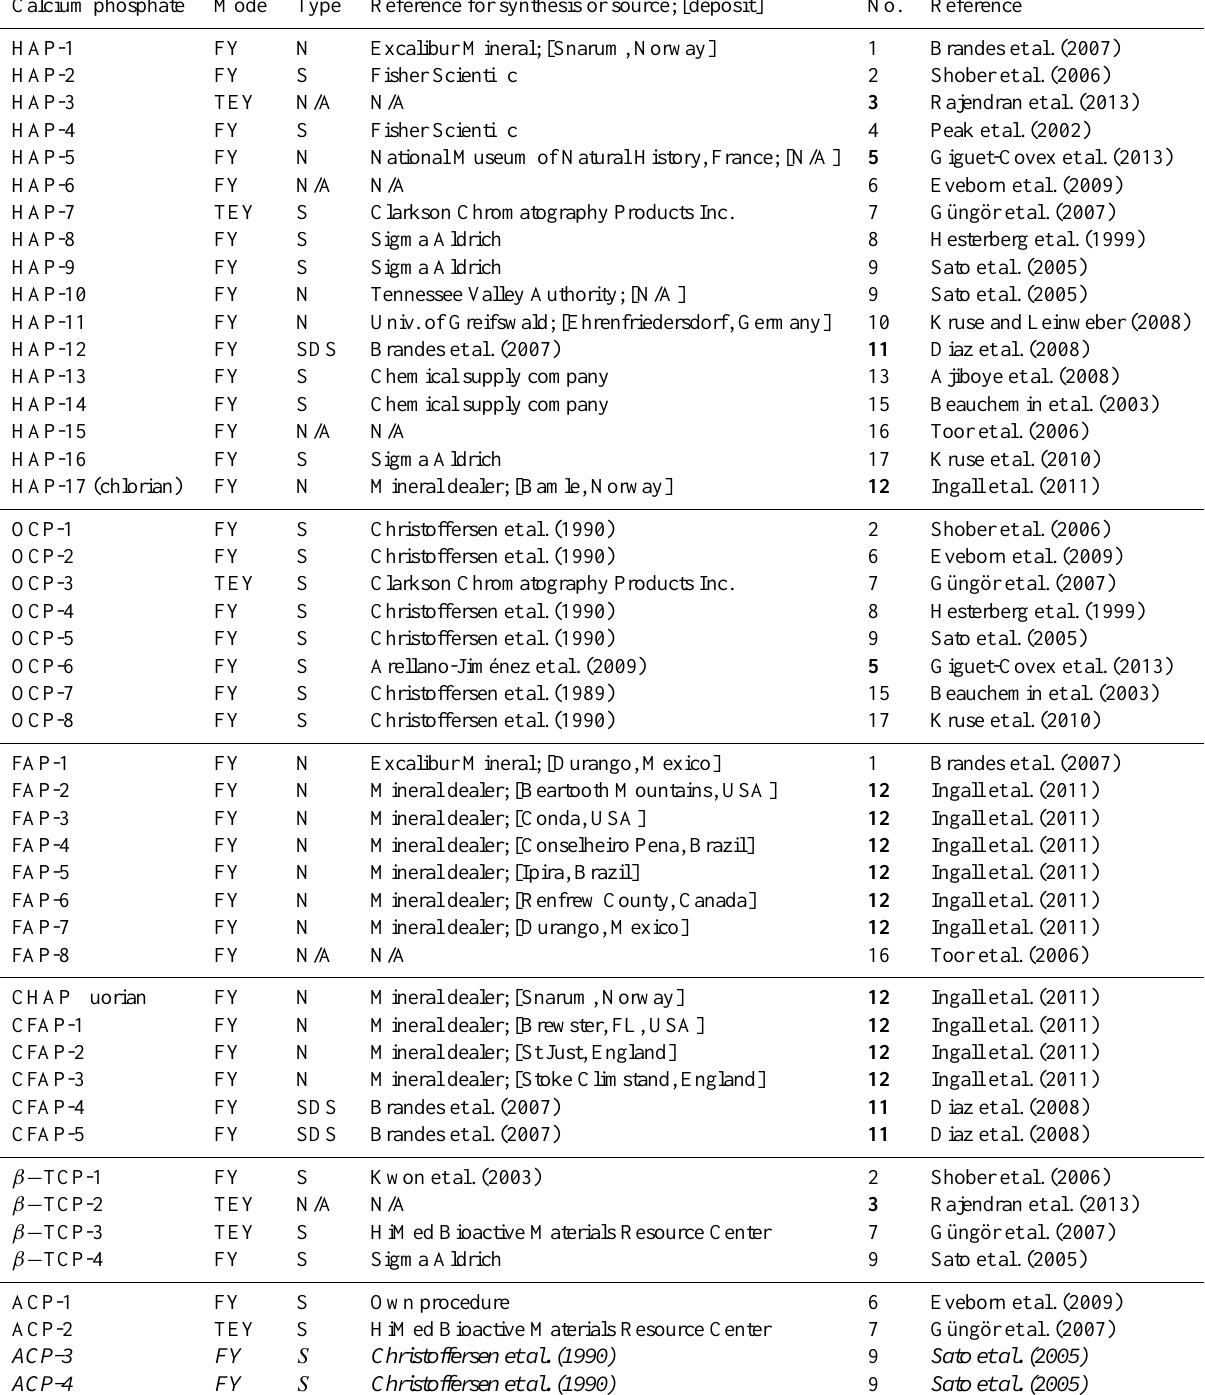
Table 1. Compiled library of P K-edge XANES spectra for calcium phosphate standards. Calcium